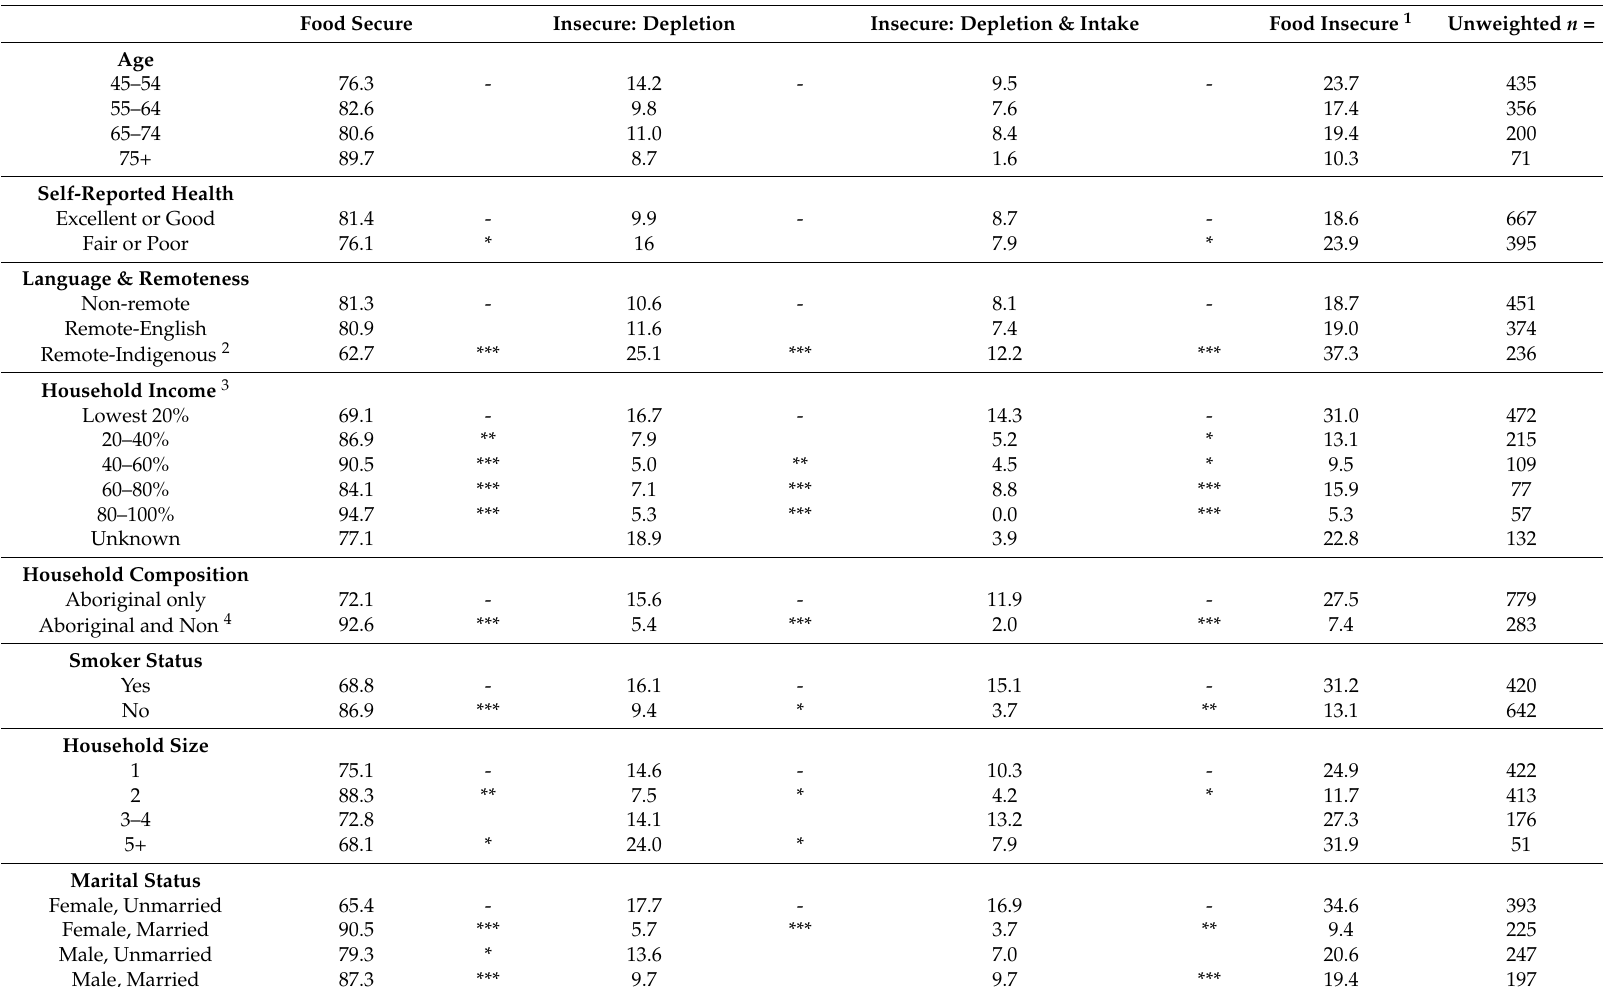
Table 1. Food Insecurity (%) by Socio-Economic Characteristics,